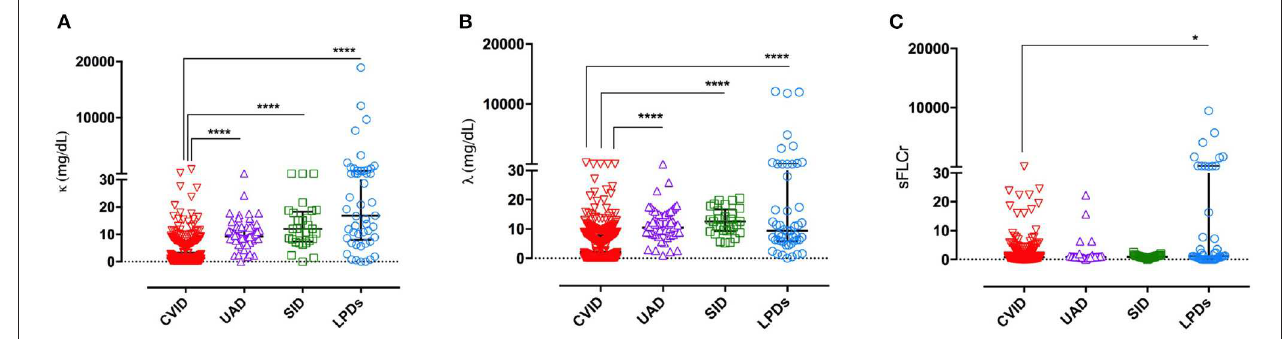
FIGURE 1 | sFLC levels in the differential diagnosis of hypogammaglobulinemia. CVID patients displayed lower of κ chains serum levels (A) and lower λ chains serum levels (B) in comparison to UAD, SID and LPDs groups. CVID had also lower FLCr in comparison to LPDs (C) . Individual values, median, and IQR are represented. Levels of significance for comparison with CVID group by u test: * P ≤ 0.05, **** P ≤ 0.0001.